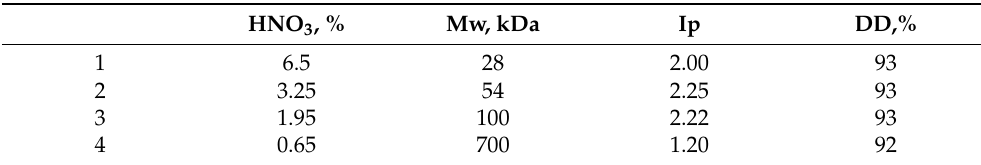
Table 2. Influence of the concentration of nitric acid during hydrolysis of chitosan * on the character- istics of the obtained samples.